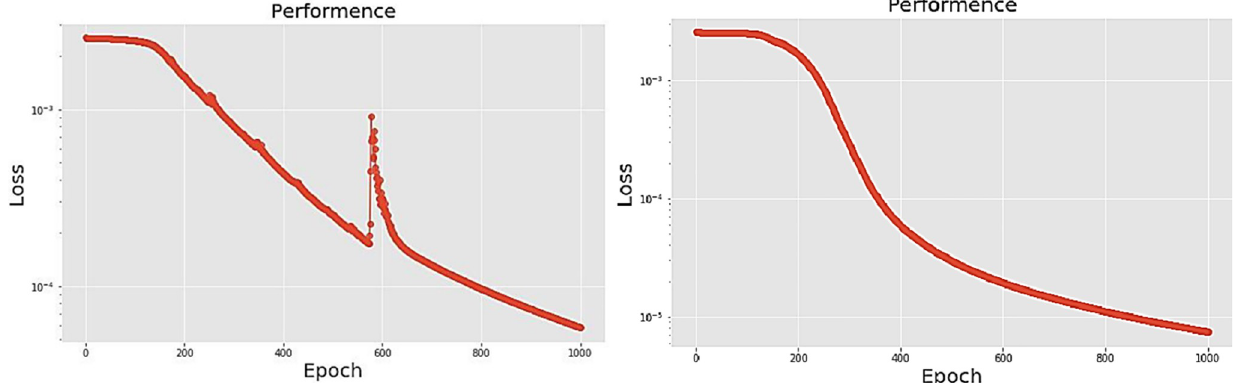
Fig 23. (a) The graph shows the performance of LPC-LSTM-2 × 500 model; (b) The graph shows the performance of LPC-PCA-LSTM-2 × 500